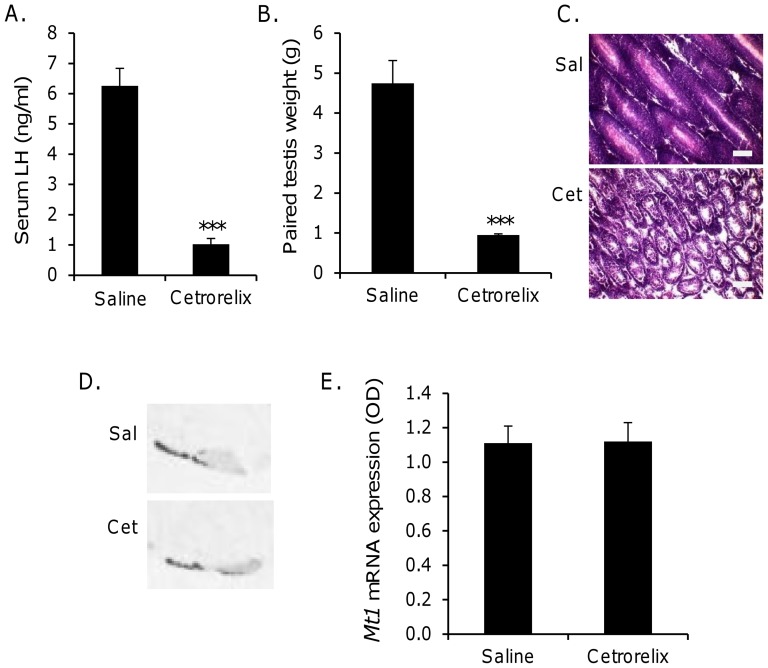
Treatment of rats with GnRH antagonist impairs reproductive status but does not affect Mt1 expression.Male Wistar rats were given a daily i.p. injection of the GnRH antagonist cetrorelix (100 µg/day) or saline control for 4 weeks. (A) Serum LH was measured by ELISA. (B–C) Testis morphology was assessed by (B) paired testis weight and (C) histological analysis of tissue sections using hematoxylin and eosin staining. Scale bar = 25 µm (D–E) Brain and pituitary tissue from saline and cetrorelix-treated rats was dissected with the pituitary stalk intact, frozen on dry ice and stored at −80°C. Twenty micron sagittal sections were cut and Mt1 mRNA expression determined by in situ hybridisation histochemistry. (D) Representative autoradiographs. In both treatment groups, strong pituitary expression was observed in the pars tuberalis and along the rostral extent of the ventral pars distalis; weaker expression was observed throughout the rest of the pars distalis. (E) Quantification of Mt1 expression by densitometry. *** p<0.001 saline vs cetrorelix group (unpaired t-test). Sal: saline-treated; Cet: cetrorelix-treated.